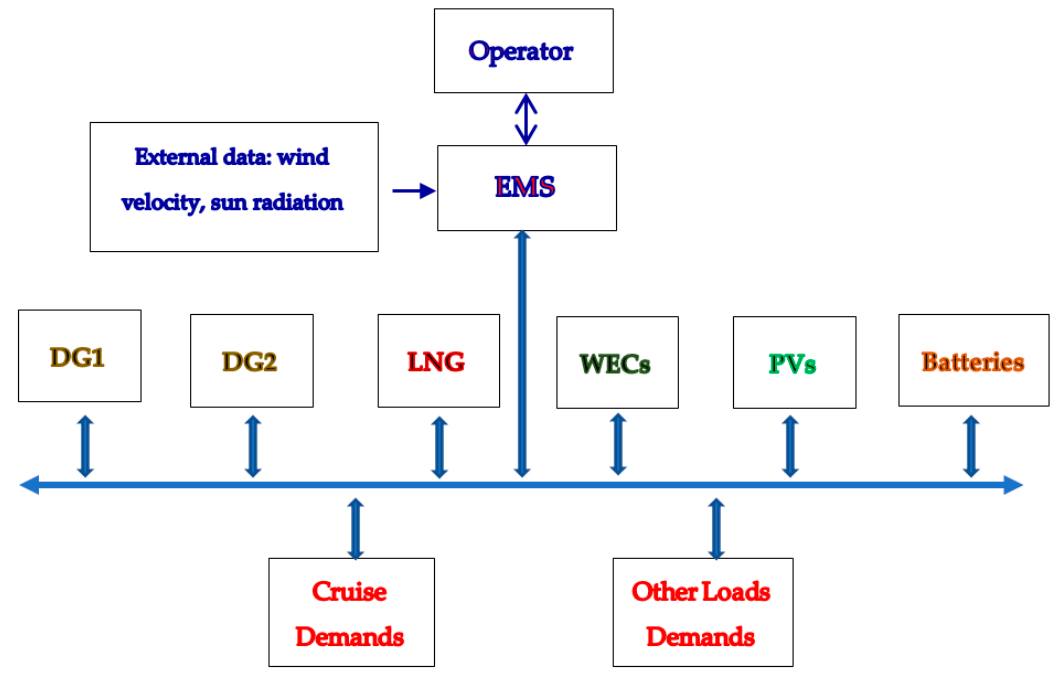
Figure 1. The ship energy control system with EMS, generating units and electric loads.